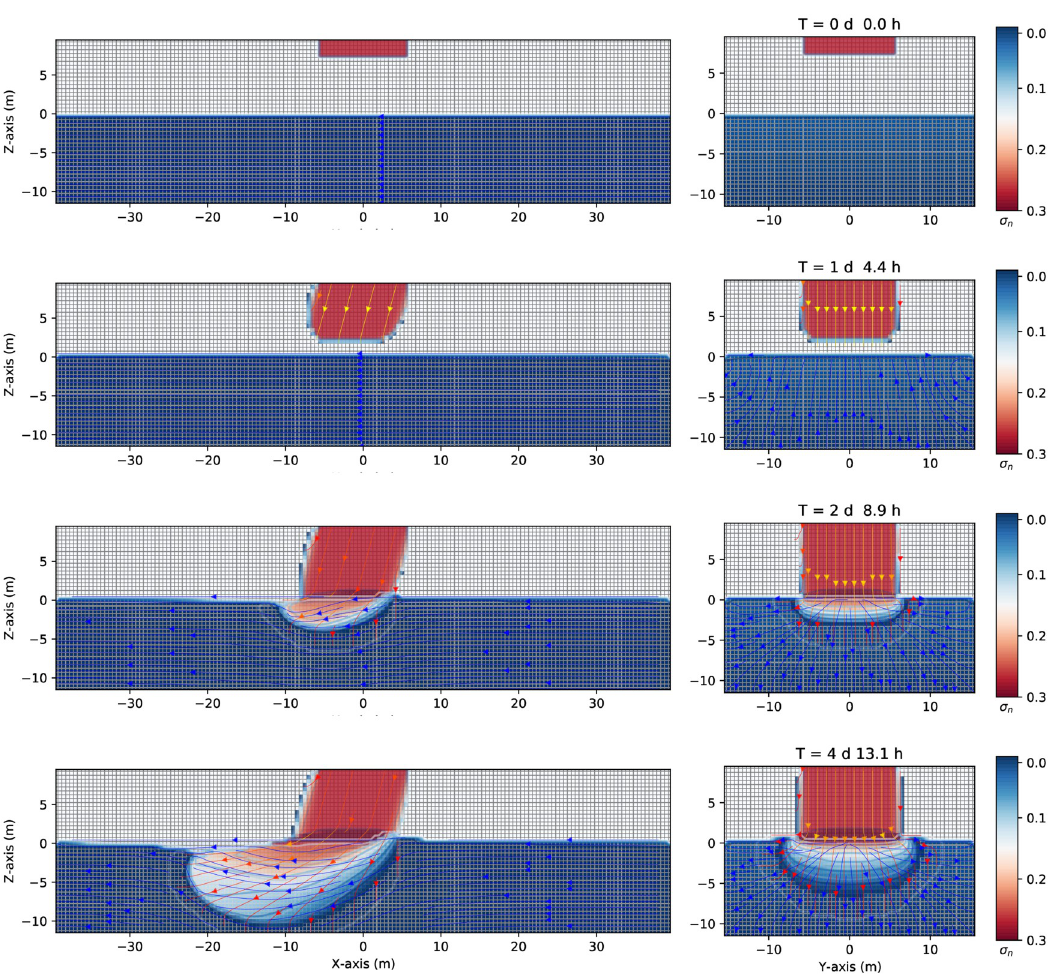
Fig 5. Saturation contours of DNAPL (continuous source) at different times. Three-dimensional numerical simulation results of the saturation contours ( σ = S ) of a three-phase immiscible fluid flow (water + a continuous source of DNAPL + air) using a n n ϕ spatial grid resolution of 0.50 m and a grid dimension of 80 m × 32 m × 22 m , at different times. The left-hand side shows the saturation contours in the ( z − x ) plane. The right-hand side shows the saturation contours in the ( z − y ) one. Notice how the DNAPL migrates through the saturated zone while moving in the left direction (where it is positioned a gravity at 15 degrees in the z–x plane, left-hand side). The difference between the previous case (Fig 2) is that now the continuous leak of DNAPL keeps moving to the bottom (aquiclude) of the saturated zone while moving in the left direction due to the pressure